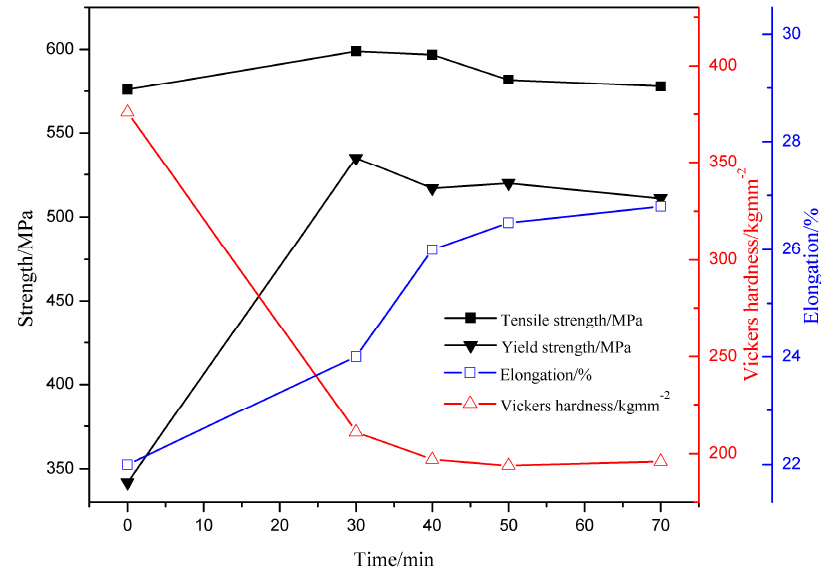
Figure 4. Mechanical properties of cold-rolled specimens annealed at 650 °C and different holding times. The first value of yield strength, tensile strength, and elongation belongs to the dual-phase steel (the Vickers hardness of the dual-phase steel was 194 HV). The first value of Vickers hardness belongs to the dual-phase steel after cold rolling (The values of yield strength, tensile strength, and elongation of the dual-phase steel after cold rolling were 1008 MPa, 1125 MPa, and 4.7%, respectively).